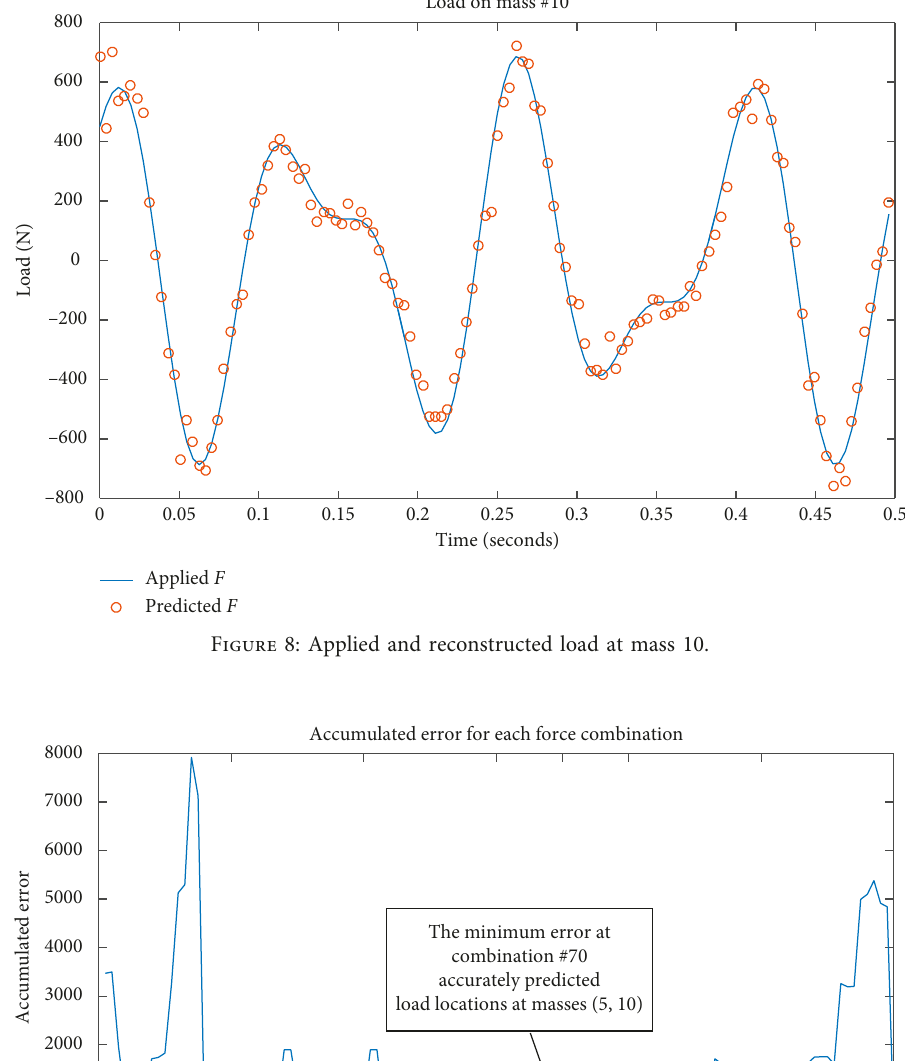
Figure 9: Accumulated error with 5 optimally placed sensors and measurement